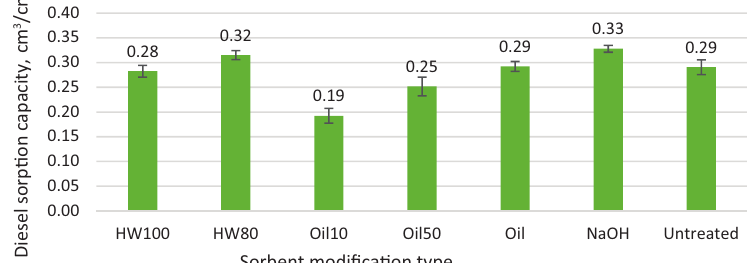
Figure 3. Diesel sorption capacity of